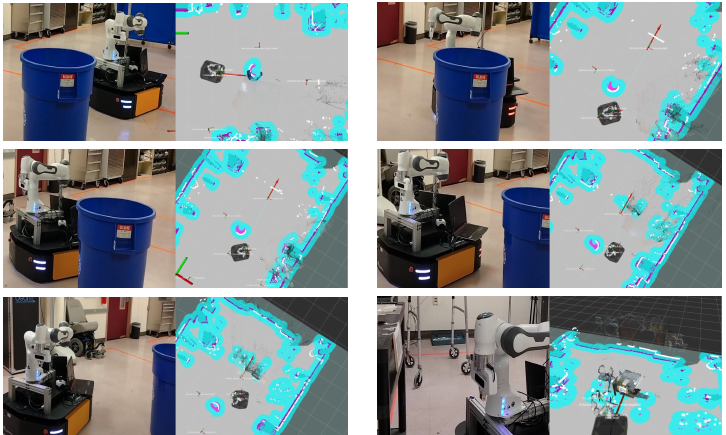
Figure 14. Robot motion while avoiding the obstacle in the path to the experimental cart: ( top left ) robot detecting the obstacle; ( top right , middle left , middle right , bottom left ) robot moving around the obstacle; ( bottom right ) robot moving to Anchor 2 waypoint after avoiding the